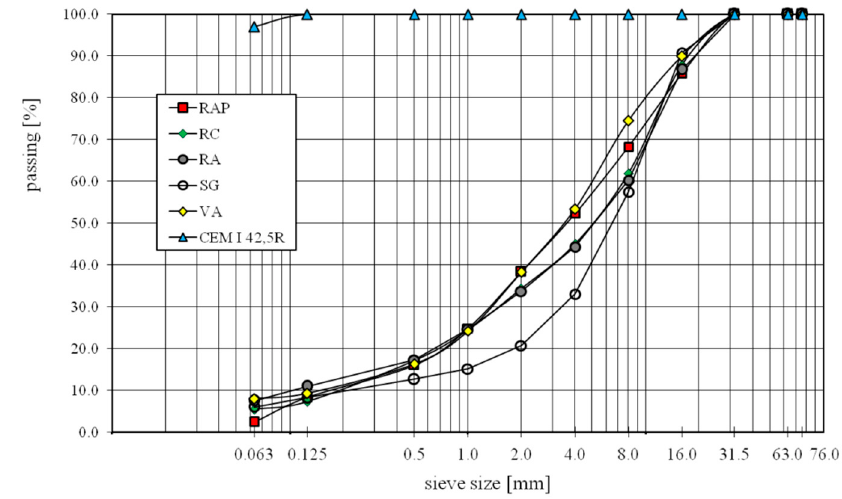
Figure 1. Grading curves of the waste materials.